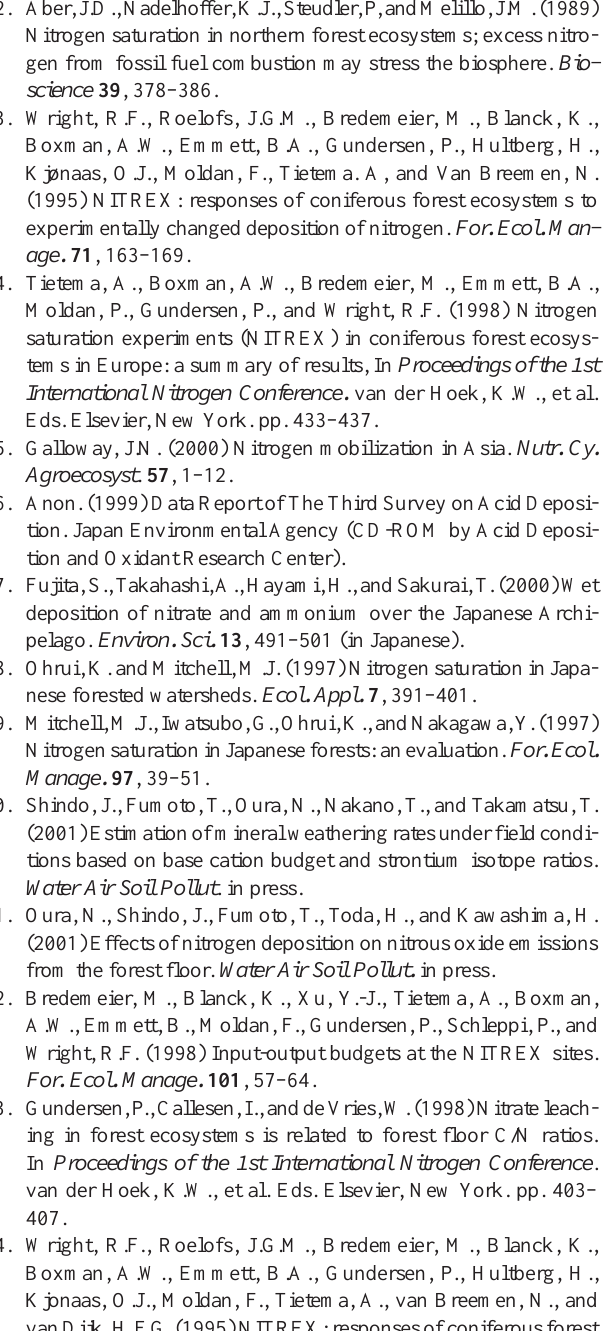
emission from (a) fertilized soil and (b) livestock 3